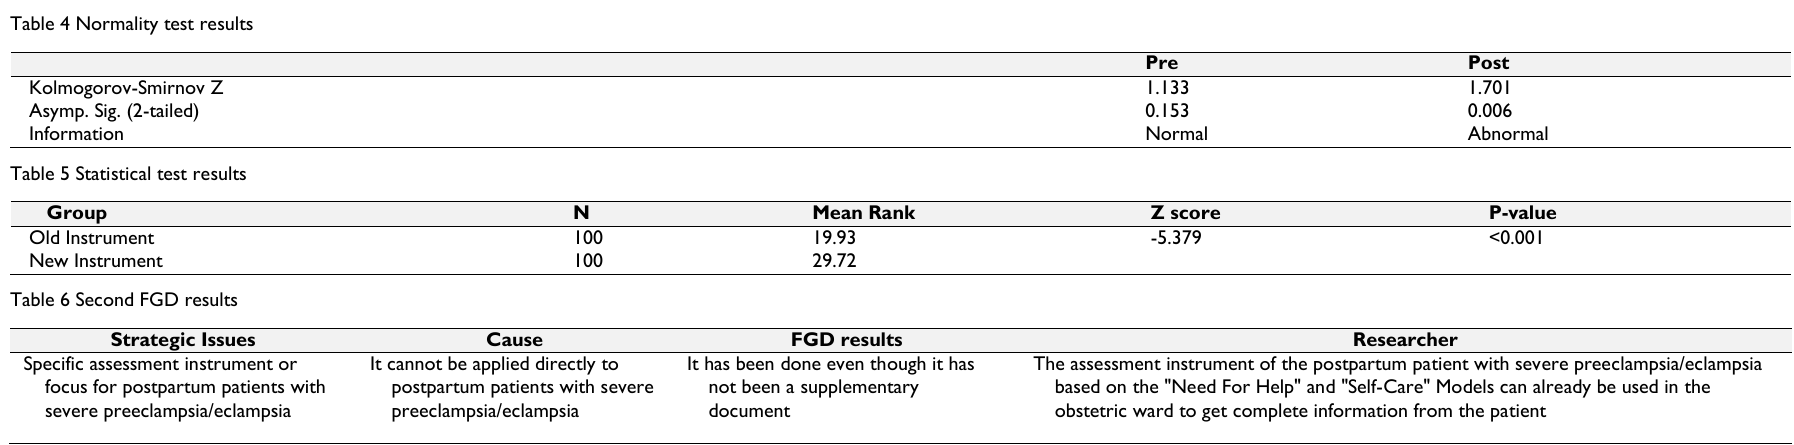
Table 4 Normality test results